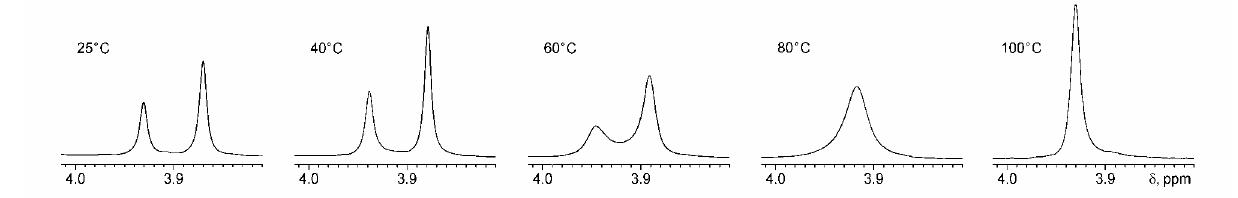
Figure 1. Variable temperature 1 H-NMR (400 MHz, DMSO-d